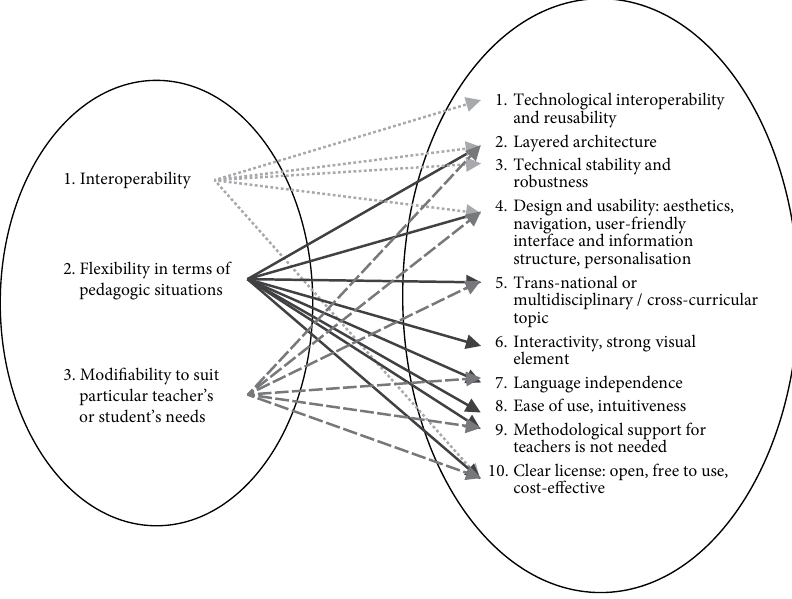
Fig. 2. Relationships between LOs reusability elements and quality